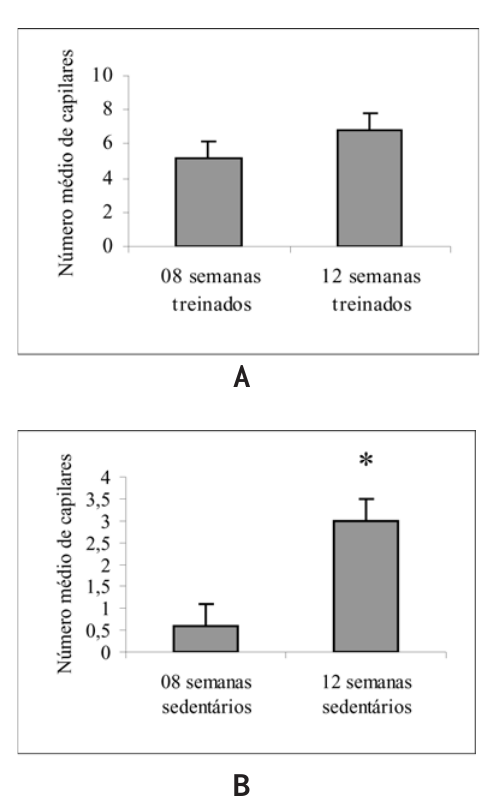
FIGURA 3 - Valores médios do número de capilares no músculo vasto medial direito. A. animais submetidos ao treinamento de endurance durante 8 e 12 semanas após a ligadura da artéria femoral direita; B. animais sedentários durante 8 semanas após a ligadura da artéria femoral direita. *Relação estatisticamente significante (P < 0,05, para o Teste de